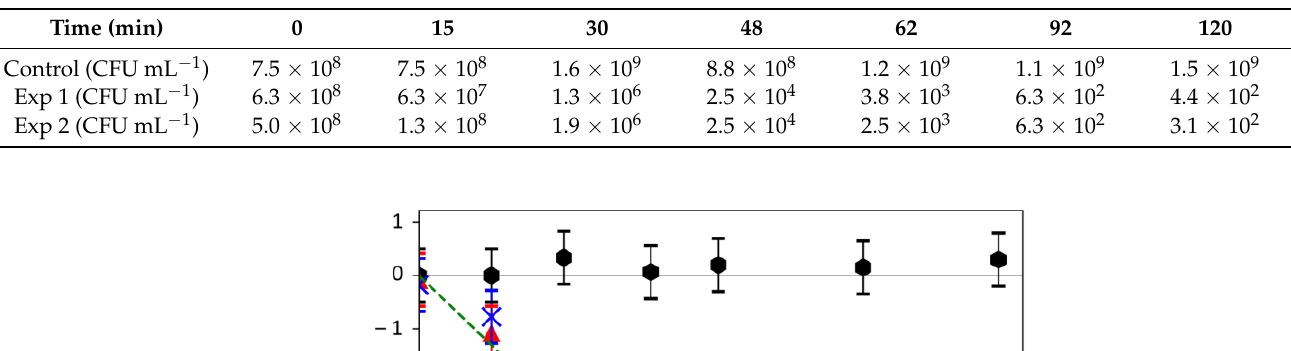
Table 3. Bacterial concentration N (colonies forming units (CFU) mL − 1 ) measured over time for two experiment replicates (Exp 1 and Exp 2, respectively). A control reactor without Ag + ions was carried out simultaneously.